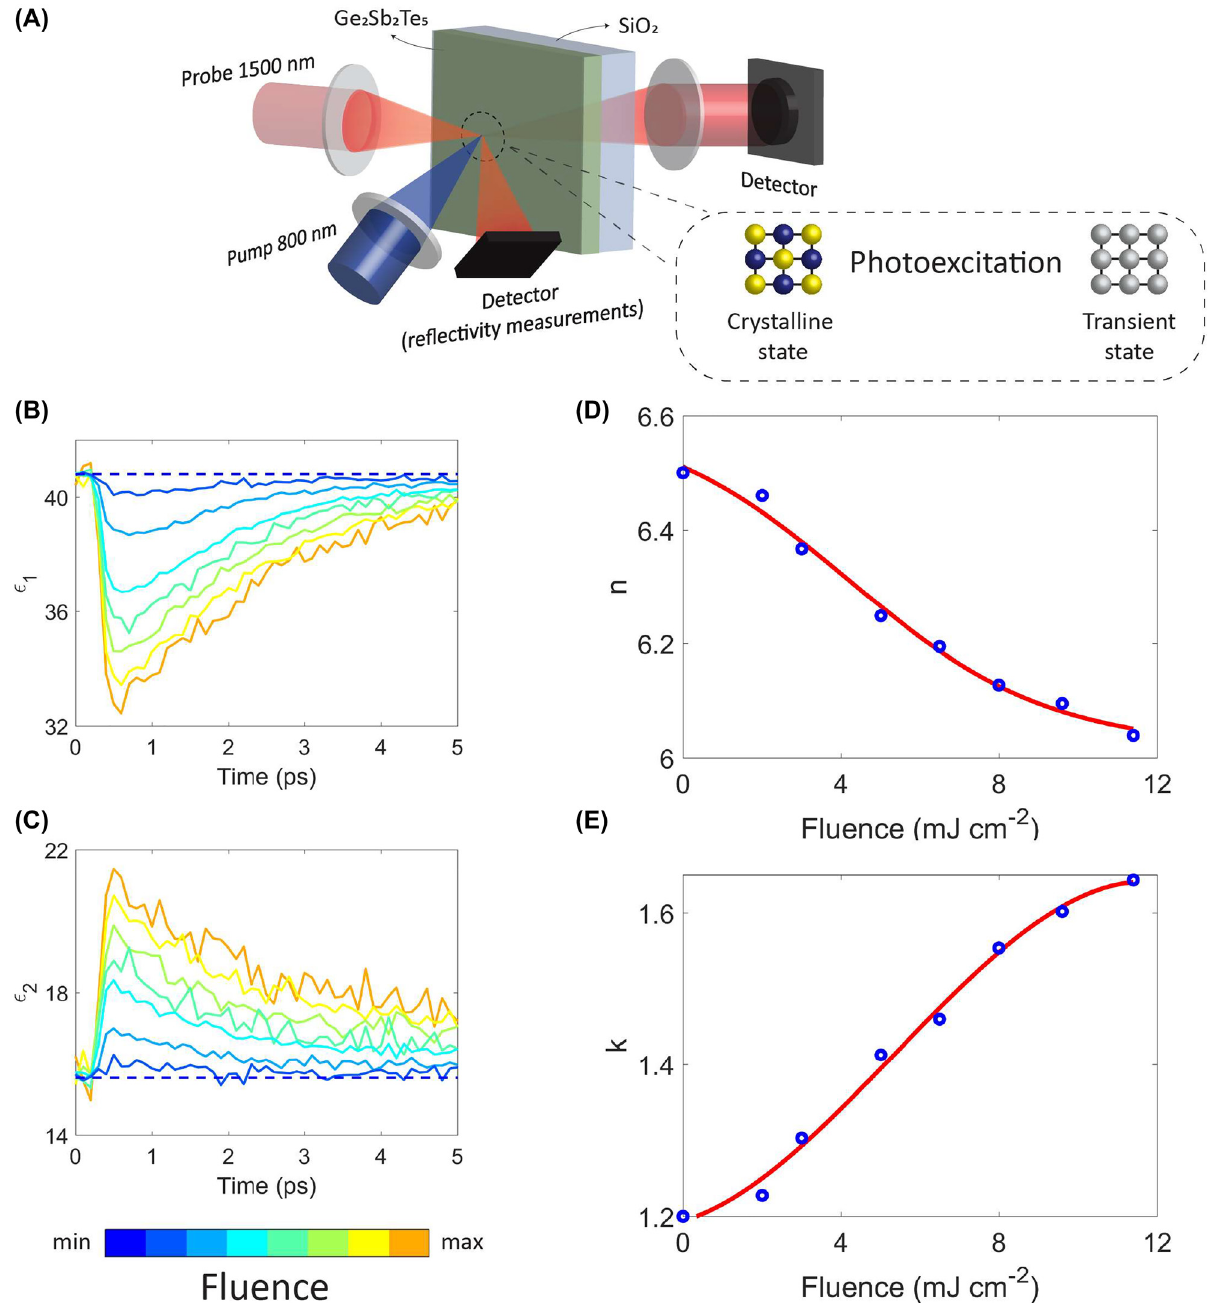
Figure 3: Femtosecond time-resolved pump – probe measurement of crystalline Ge 2 Sb 2 Te 5 . (A) Pump – probe experimental setup. Variation in the(B)realand(C)imaginarypartofthedielectricfunctionwithtimeat1500nmwavelengthwhenGe 2 Sb 2 Te 5 isexcitedwitha35fslaserpulse at 800 nm wavelength. Corresponding (D) refractive index, n , and (E) extinction coef fi cient, k , of Ge 2 Sb 2 Te 5 at 1